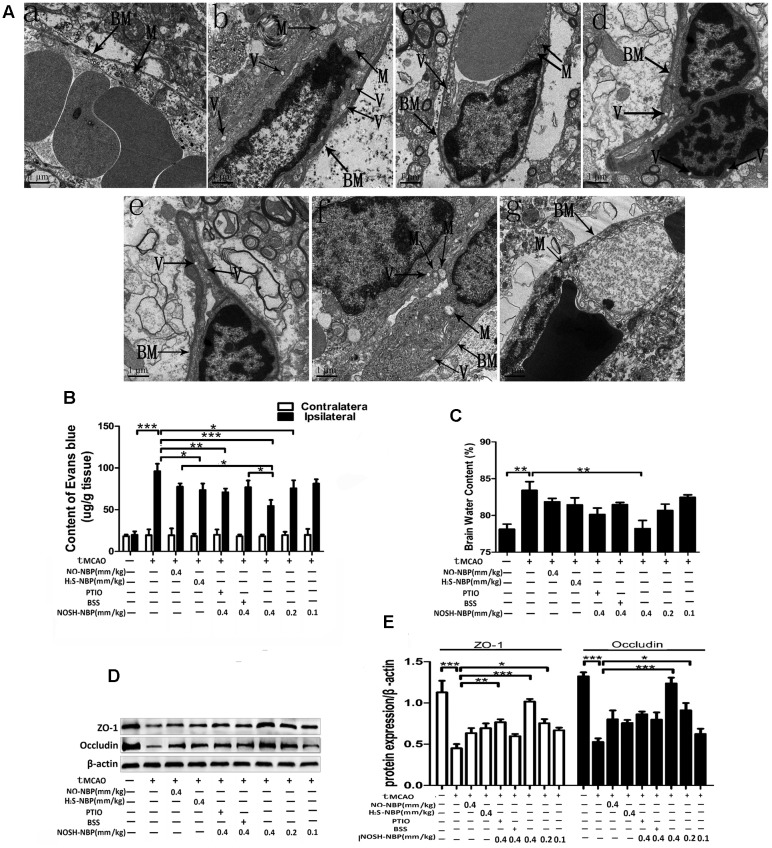
Effect of NO-NBP, H2S-NBP, and NOSH-NBP on BBB breakdown in tMCAO mice. The model- group and test compounds- groups underwent tMCAO; the sham group underwent the same surgical procedure without the filament insertion. After MCAO completion, mice in test compound groups were administered with NO-NBP (0.4 mm/kg), H2S-NBP (0.4 mm/kg), NOSH-NBP (0.4 mm/kg)+PTIO, NOSH-NBP (0.4 mm/kg)+BSS or NOSH-NBP (0.4, 0.2, and 0.1 mm/kg) for 3 days. (A) Electron micrographs of microvessel cross sections of rats in the (a) control, (b) model, (c) tMCAO + NO-NBP (0.4 mm/kg), (d) tMCAO + H2S-NBP (0.4 mm/kg), (e) tMCAO + NO-NBP (0.4 mm/kg) + PTIO, (f) tMCAO + NO-NBP (0.4 mm/kg) + BSS and (g) tMCAO + NOSH-NBP (0.4 mm/kg) groups. BM, basement membrane; M, mitochondria; V, vacuolation. (B) Quantitative analysis of EB content in ischemic (ipsilateral) cortex and non-ischemic (contralateral) cortex (n = 4). (C) Quantitative analysis of brain water content in the brains (n = 6). (D) Representative Western blot membranes for occludin and ZO-1 proteins expressions. (E) Quantitative analysis of occludin and ZO-1 proteins expressions levels (n = 3). Data are expressed as the mean ± SD and were analyzed by one-way ANOVA followed by post hoc Tukey test: ∗∗∗P < 0.001, ∗∗P < 0.01, ∗P < 0.05.